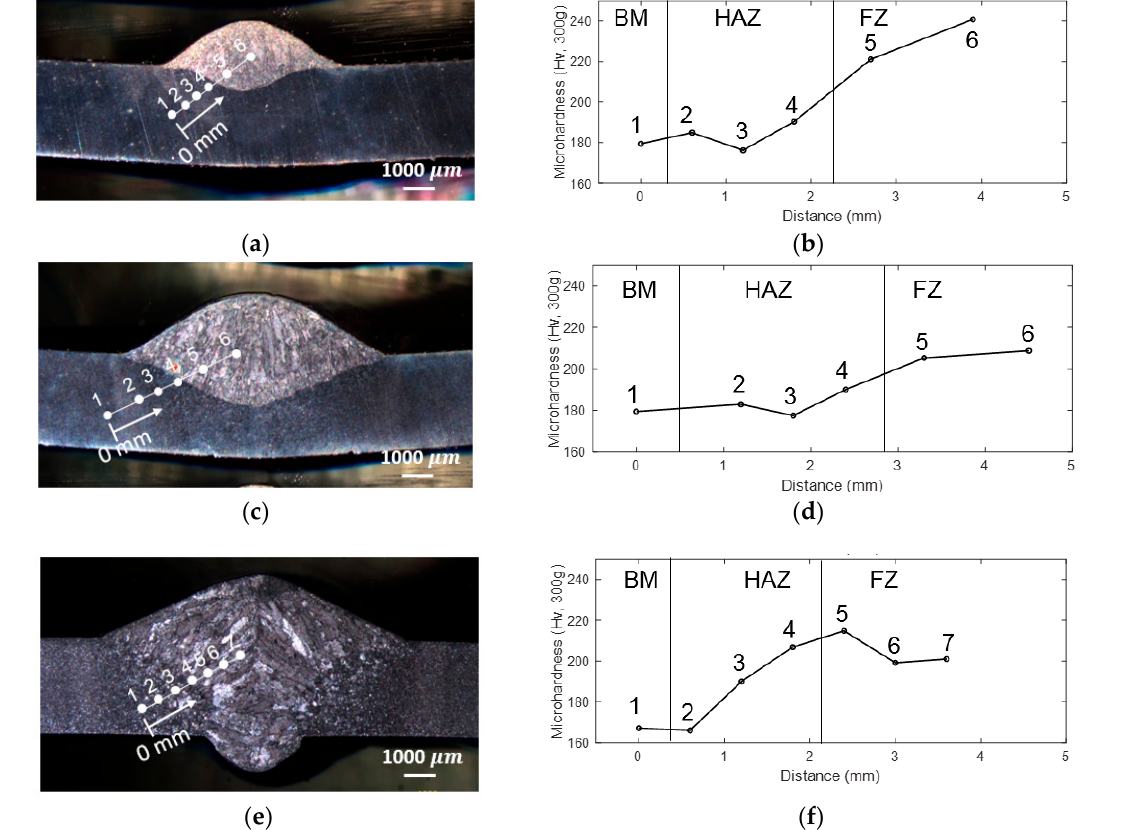
Figure 14. The testing positions of microhardness in ( a ) P1, ( c ) P4 and ( e ) P6 and their microhardness values of ( b ) P1, ( d ) P4 and ( f ) P6. (BM: Base Metal; HAZ: Heat Affected Zone; FZ: Fusion Zone)